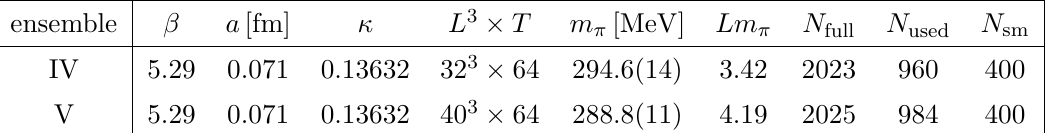
Table 1. Details of the ensembles used in this analysis. N full is the total number of available gauge con(cid:12)gurations and N used the number of con(cid:12)gurations used in the present study. N sm indicates the number of Wuppertal smearing iterations in the pion source. The error on the pion mass combines statistical and systematic errors, see [15]. The time di(cid:11)erence between pion source and sink is t = 15 a or t = 32 a for both